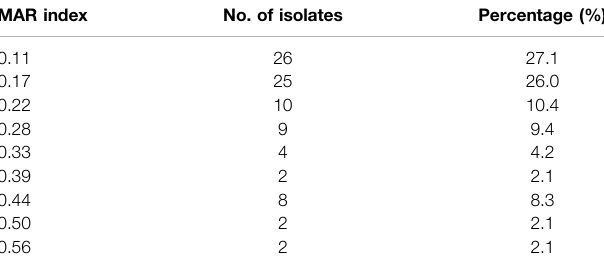
TABLE 3 | Multiple antibiotic resistance (MAR) index of the